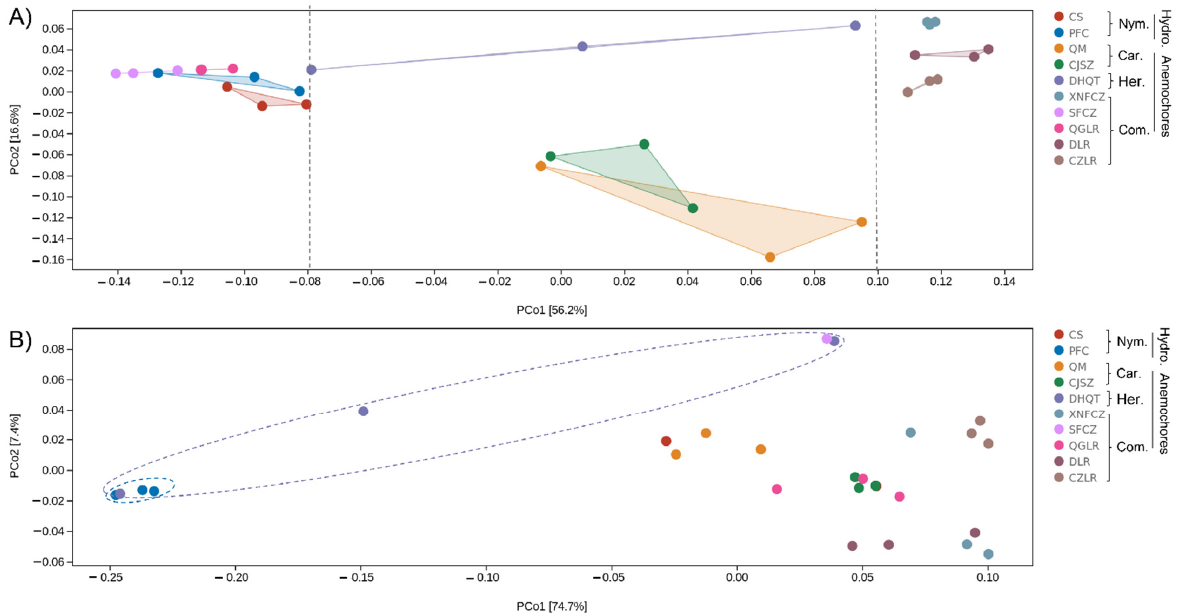
Figure 5. PCoA (principal co-ordinates analysis) of seed endophytic bacterial ( A ) and fungal ( B ) functional units (metabolism pathways and EC enzyme classification number from MetaCyc database). Dots of same color represent plant species. Percentages in brackets represent the proportion of sample variance data (Bray–Curtis distance matrix) that can be explained by the corresponding axes. The closer the distance of the two points on the coordinate axis, the more similar the functional composition of the two samples. The abbreviations behind the bracket indicate plant family name (Car, Caryophyllaceae; Com, Combretaceae; Her, Hernandiaceae; Nym, Nymphaeaceae) and their assigned dispersal mode (hydrochores/anemochores), including two hydrochoric herbs (CS, Euryale ferox ; PFC, Nuphar pumila ), two anemochoric herbs (QM, Dianthus superbus ; CJSZ, Dianthus repens ), three anemochoric vines (DHQT, Illigera grandiflora ; XNFCZ, Combretum griffithii ; SFCZ, Combretum wallichii ), and three tree species (QGLR, Terminalia myriocarpa ; DLR, Terminalia franchetii ; CZLR, Terminalia franchetii